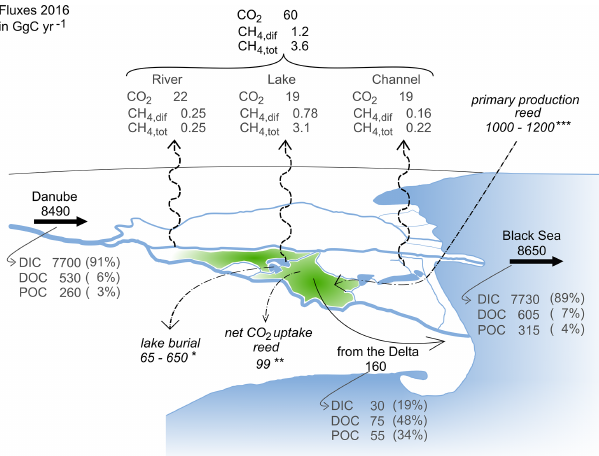
Figure 8. Overview of carbon flux estimates in GgCyr − 1 . The to- tal area between the main branches is 3510km 2 (see Table 1). Black and grey numbers refer to fluxes estimated during this study based on data from 2016. The following italicized values refer to esti- mates based on the data in the literature from different study pe- riods (studies for carbon burial and primary production do not ex- plicitly consider seasonality): ∗ carbon burial in lakes, based on av- erage sedimentation rate measured in seven lakes in the Danube Delta, with an organic carbon content range of 3%–30% (Begy et al., 2018); ∗∗ net CO 2 uptake of Phragmites australis upscaled to the area covered by the Scripo-Phragmitetum plant community (Zhou et al., 2009); ∗∗∗ upscaled primary productivity of the Scripo- Phragmitetum plant community (Sarbu, 2006). The green area in the plot symbolizes the reed area without indicating all the loca- tions of its